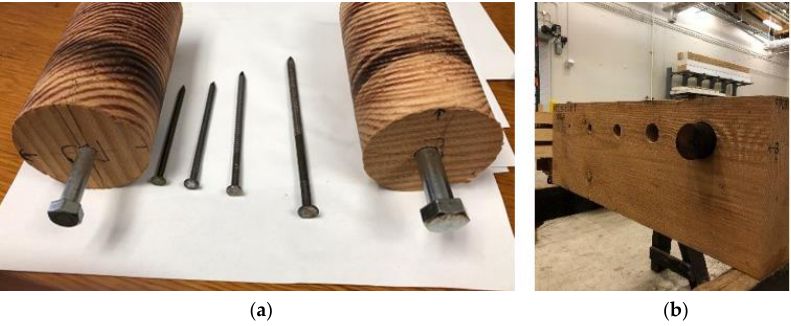
Figure 5. The testing environment of core-samples. ( a ) The core-samples inserted with metals; ( b ) The timber-section with core-samples. Table 1. The characteristics of 7 core-samples.